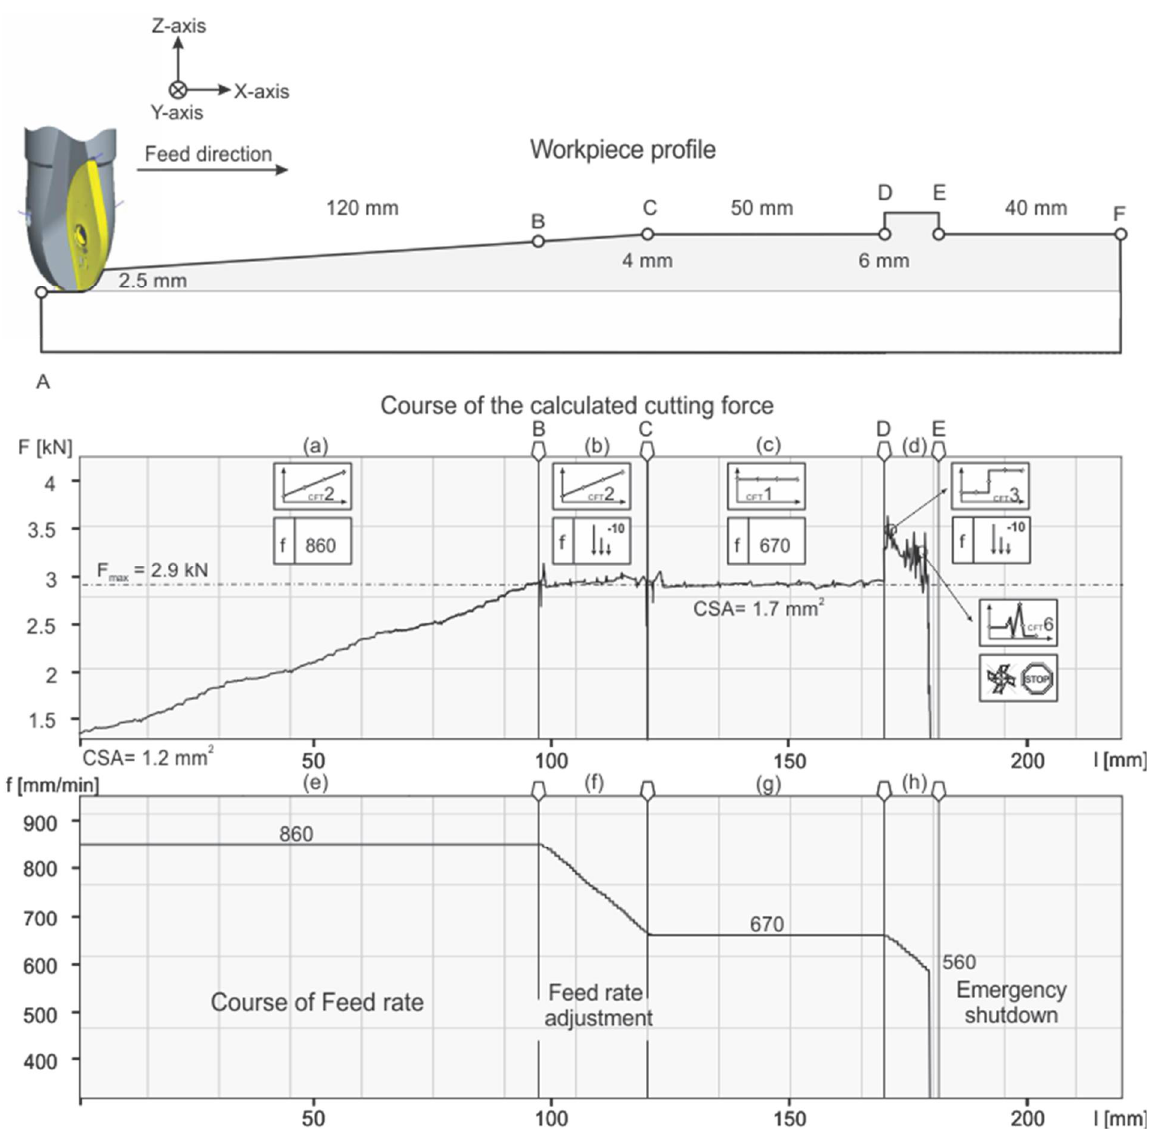
Figure 6. Results of experimental testing of TCM system with a presentation of the feed rate response to the identified cutting force trend and detected tool damage; ramp cut ( b ) with constant feed rate ( e ), ramp cut ( c ) with feed rate adjustment ( f ), normal cut ( a ) with constant feed rate ( g ) and A D step change ( d ) with corresponding feed rate reduction to 0 ( h ). Table 2. Chemical composition of 16MnCr5.